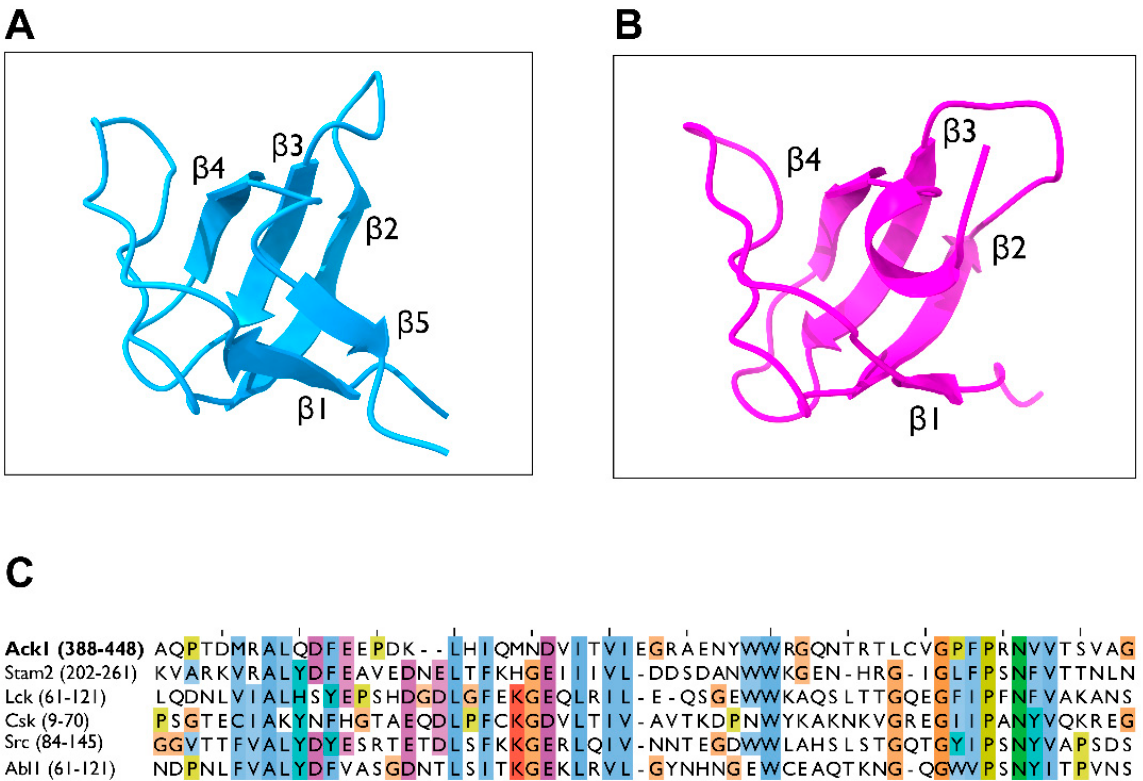
Figure 10. Structure of the SH3 domain. ( A ) Crystal structure of the Abl2 SH3 domain in the ribbon diagram (PDB: 5NP3, light blue). ( B ) Structure of the Ack1 SH3 domain (PDB: 4HZS, magenta). ( C ) Sequence alignment of the SH3 domains of human Ack1, Stam2, Lck, Csk, Src, and Abl. The num- bers in parentheses denote the residues used as the inputs.